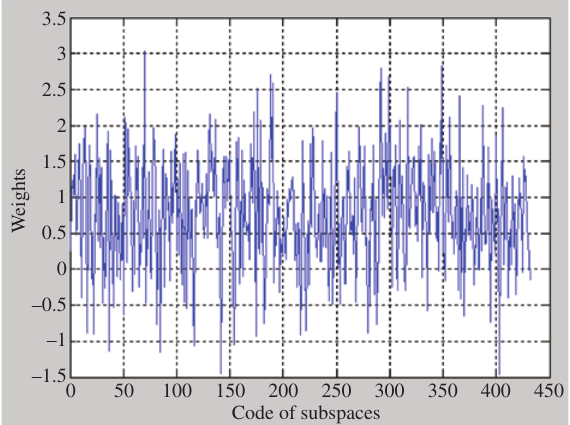
Figure 7: Result of Subspace Feature Weights.